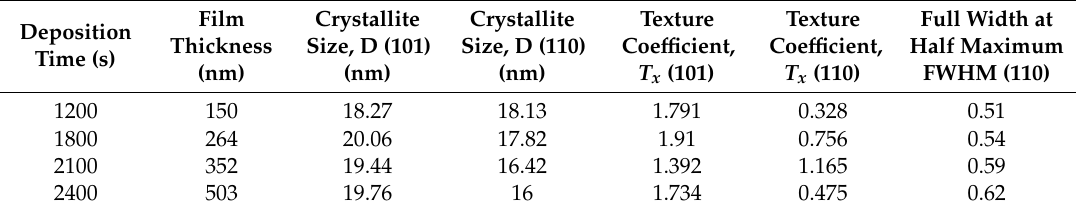
Table 1. Film thickness (nm), the crystallite size on plane (101) and (110) (nm), and the texture coe ffi cient T x for planes (101) and (110) for trigonal nickel oxide thin films.